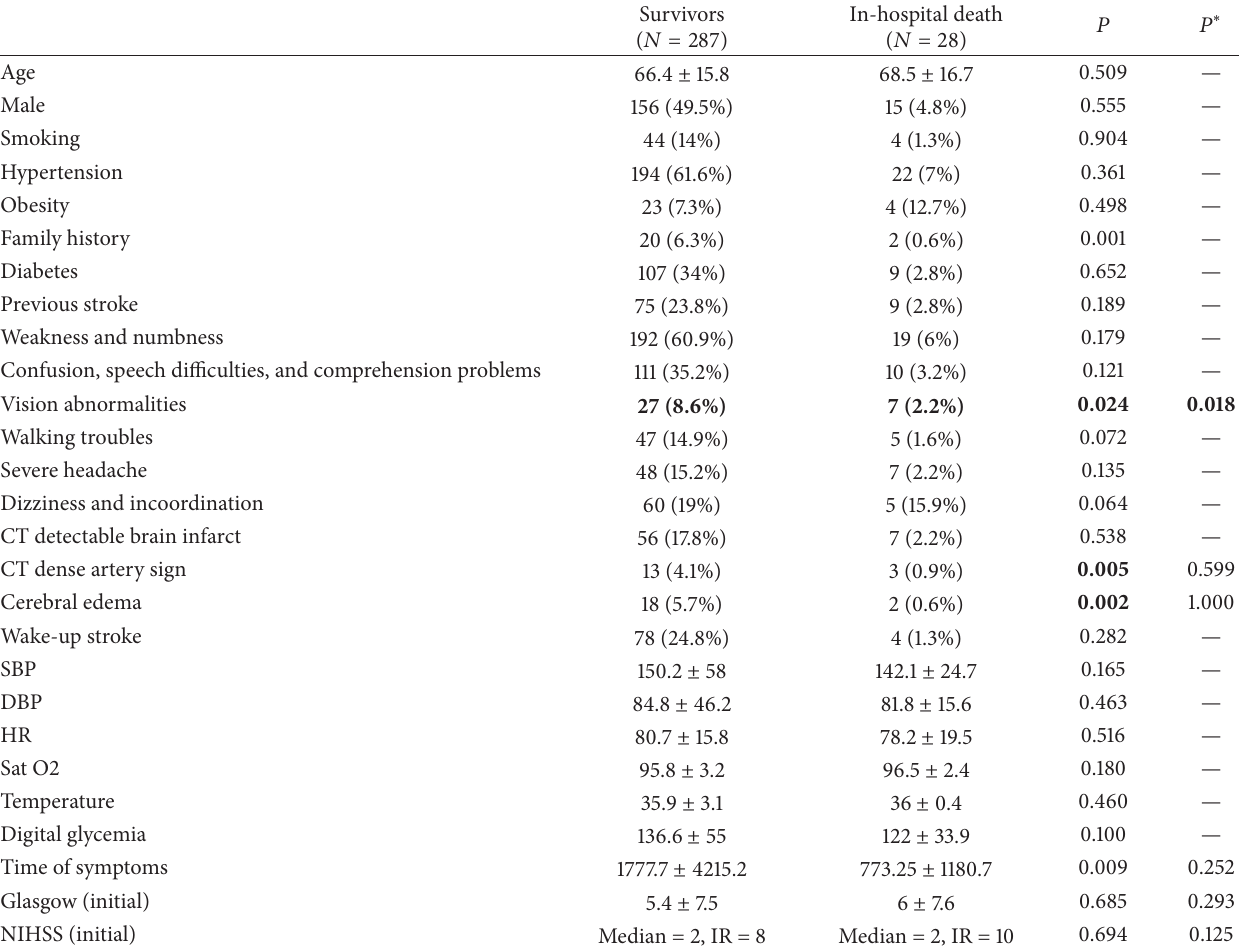
Table 3: Comparison of clinical and radiological data of survivors and patients that died during